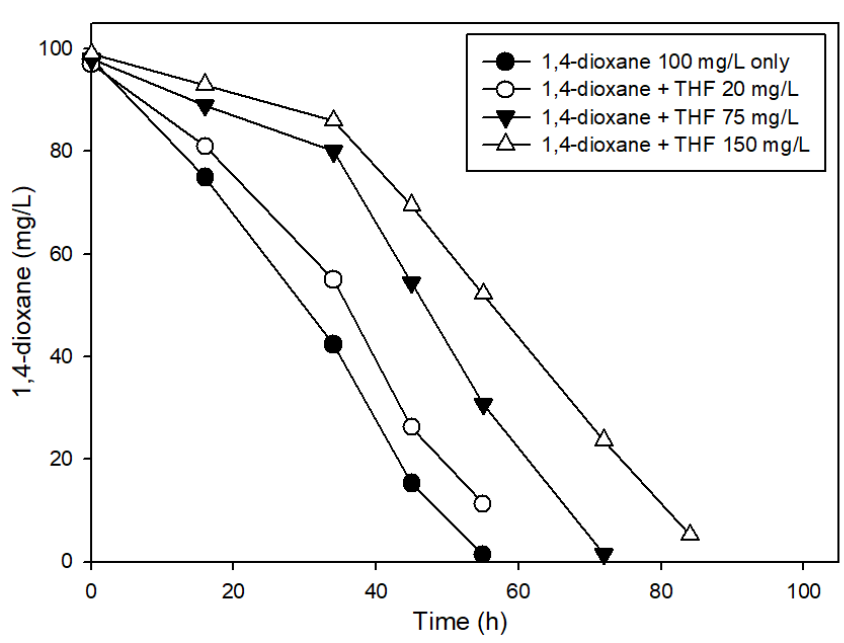
Figure 8. Biodegradation of 1,4-dioxane in the presence of THF.